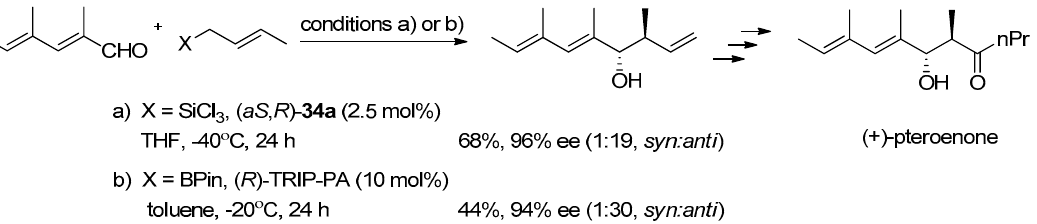
Table 6. Asymmetric allylation of benzaldehydes with allyltrichlorosilane catalyzed by 35